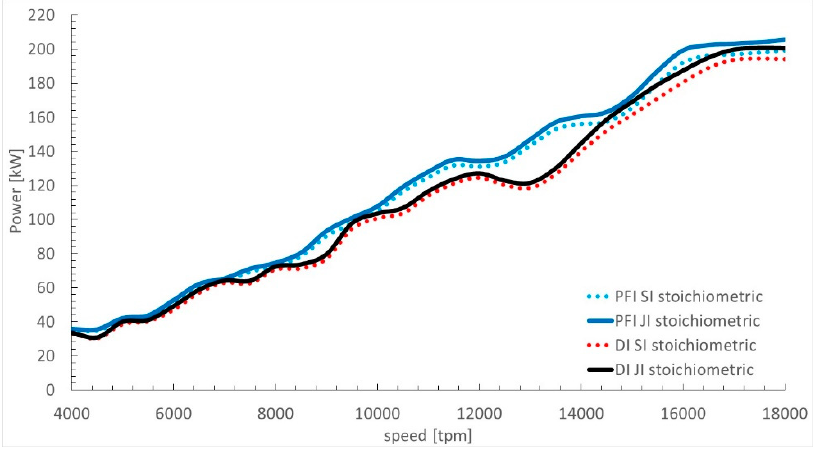
Figure 3. Power of stoichiometric engines.